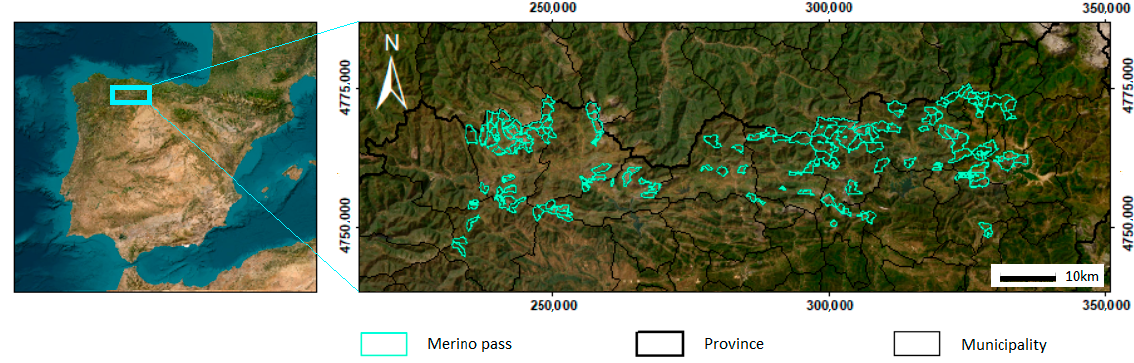
Figure 1. Location of the study region within the Iberian Peninsula (map on the left), and location of the 126 merino passes initially selected for the study (map on the right). Reference system: ETRS1989 UTM Zone 30N.